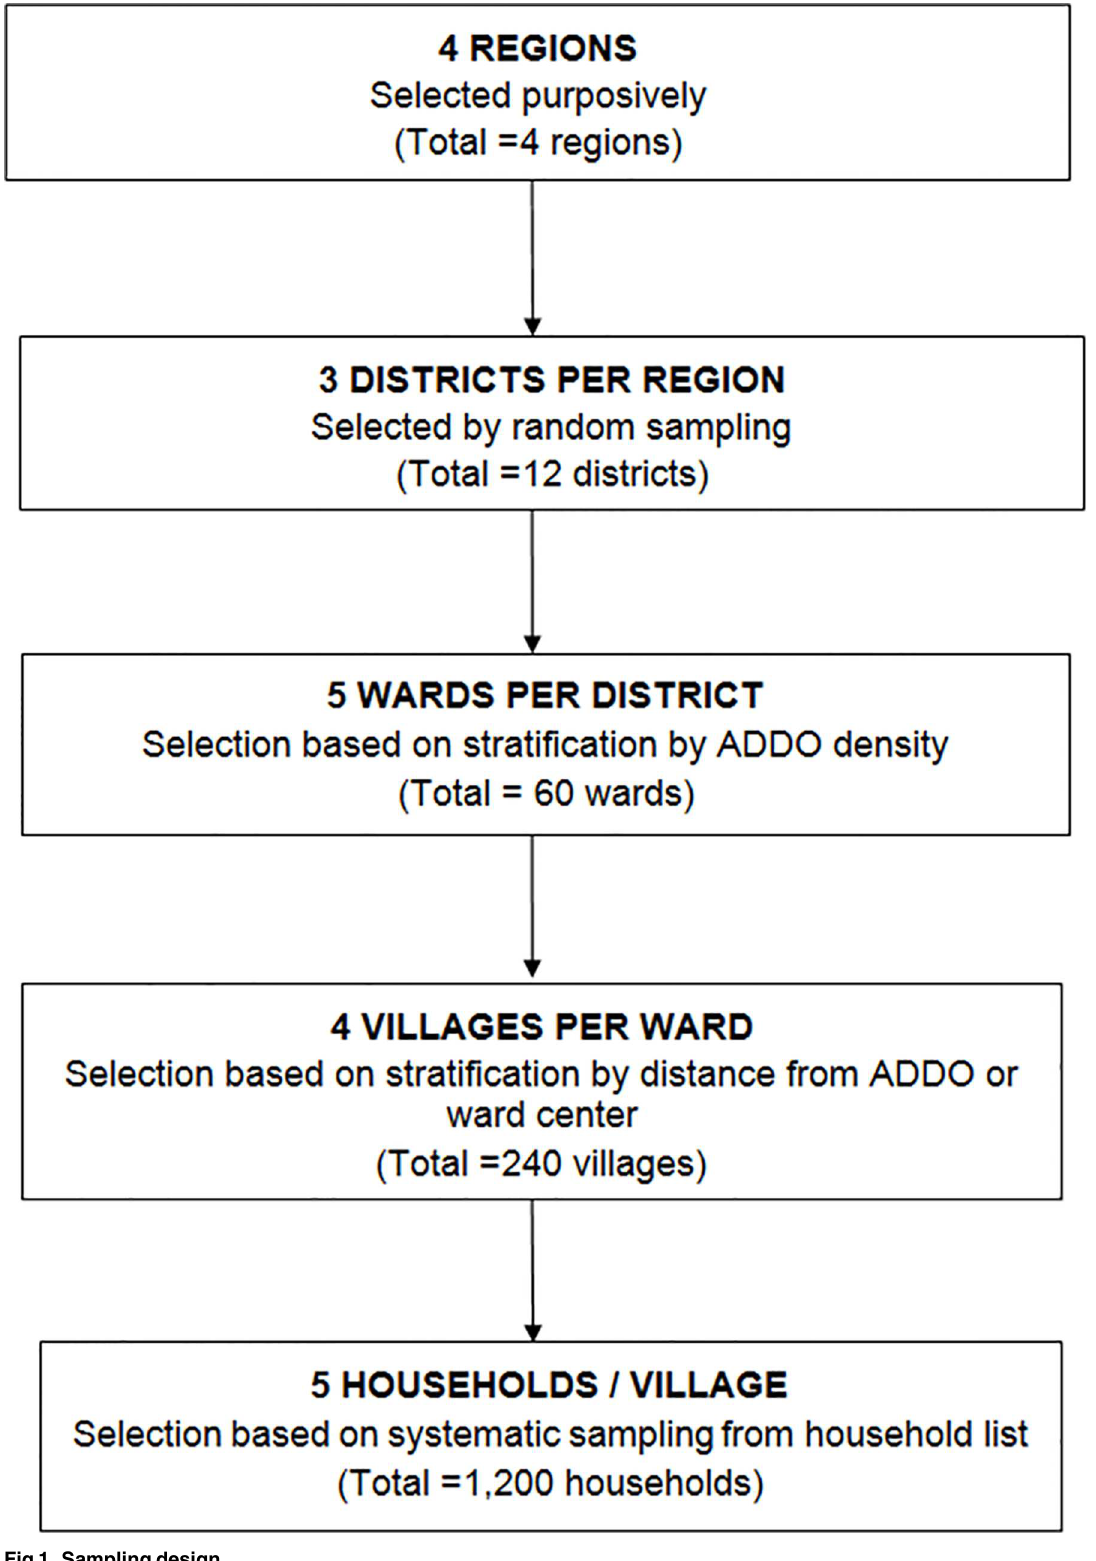
Fig 1. Sampling design.